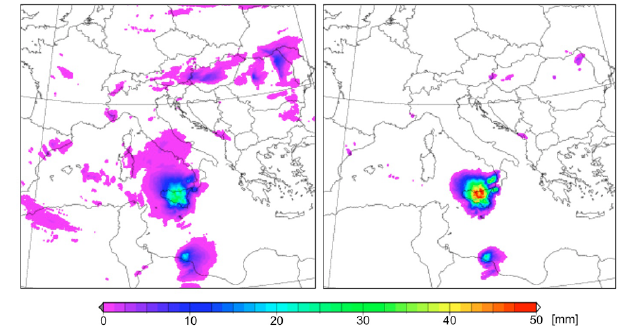
Fig. 7. Accumulated precipitation (mm) for previous three hours on 1 October 2009 at 21:00UTC, where PR-OBS-3 (left panel) and PR-OBS-6 (right panel) are used for